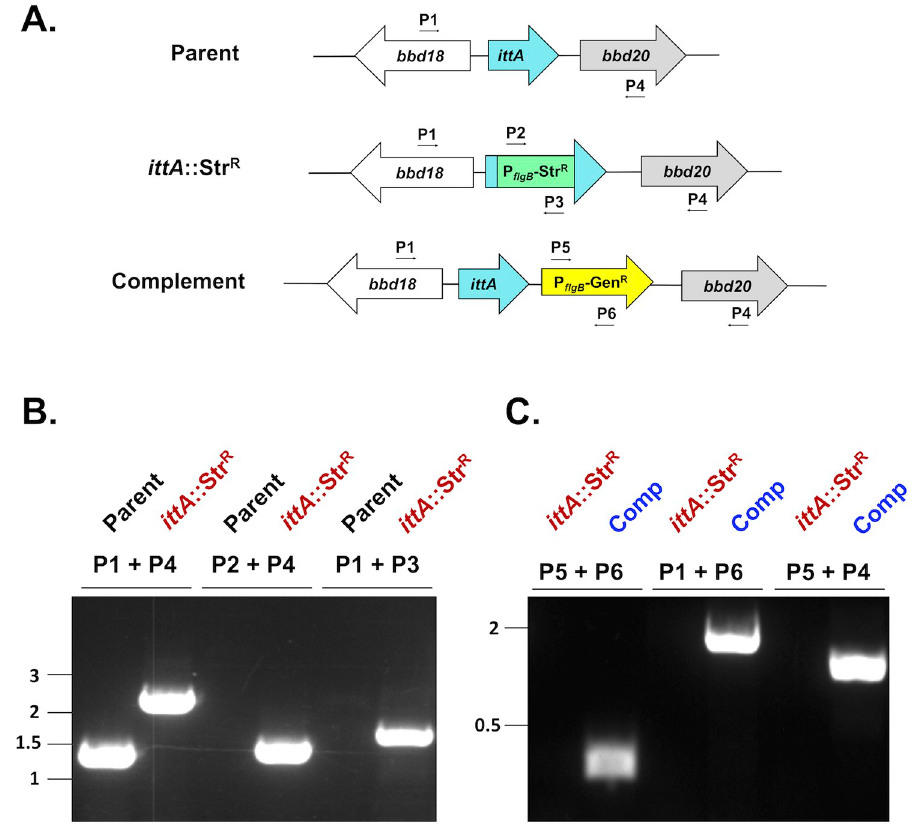
Fig 2. Strategy and confirmation of the insertional inactivation of the ittA sRNA. A. Schematic representation of ittA insertional inactivation strategy. The region of lp17 from the parent strain (ML23) is shown at the top. A P flgB - Str R cassette was inserted into the 3’ end of the ittA sRNA and the mutant (DM103) was obtained following homologous recombination. Following isolation of the mutant strain, the ittA sRNA locus was reintroduced in the complemented strain (DM113). B. Primer pairs P1/P4, P2/P4 and P1/P3 (S7 Table) were used to confirm the presence of the P in the mutant ( ittA :Str R ), relative to its parent strain by PCR. C. For the cis complementation of the ittA sRNA mutant strain, the P Str R cassette and the flanking region were replaced by the ittA sRNA sequence linked to a P flgB- cassette by a double crossover homologous recombination event. The resulting complement strain (Comp) was evaluated by PCR using primer pairs P5/P6, P1/P6 and P5/P4 (S7 Table). Note that the distances between genetic loci are not shown to scale.